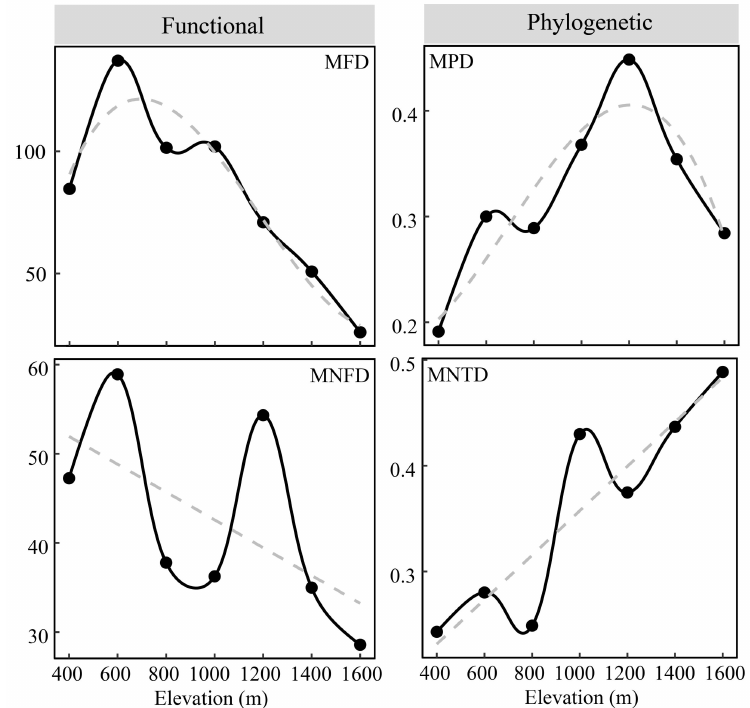
Figure 4. Elevational patterns mean pairwise functional distance (MFD), mean pairwise phylogenetic distance (MPD), mean nearest functional distance (MNFD), and mean nearest taxon distance (MNTD) of small mammals along a 1400 m elevation gradient in Qingliang Mountain, Anhui, China. The gray dashed line represents the best-fit